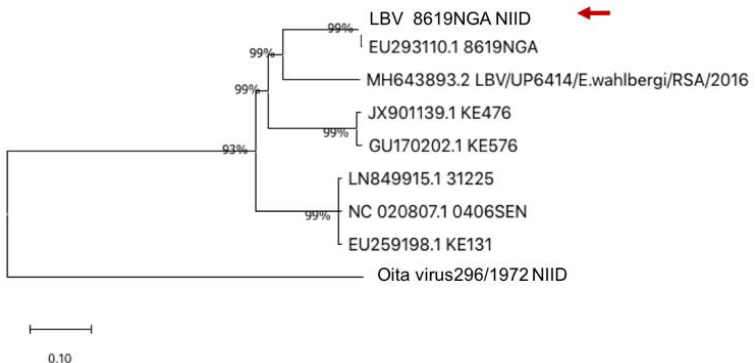
Figure 5. Phylogenetic analysis of LBV strains. Phylogenetic analysis of Lagos Bat strains using Mega10.1 software with the neighbor-joining method and 1000 bootstrap analyses. Phylogenetic analysis was performed using the LBV-8619NGA-NIID strain and other Lagos Bat viral strains that have been analyzed and deposited in GenBank. The Oita virus was the outgroup.